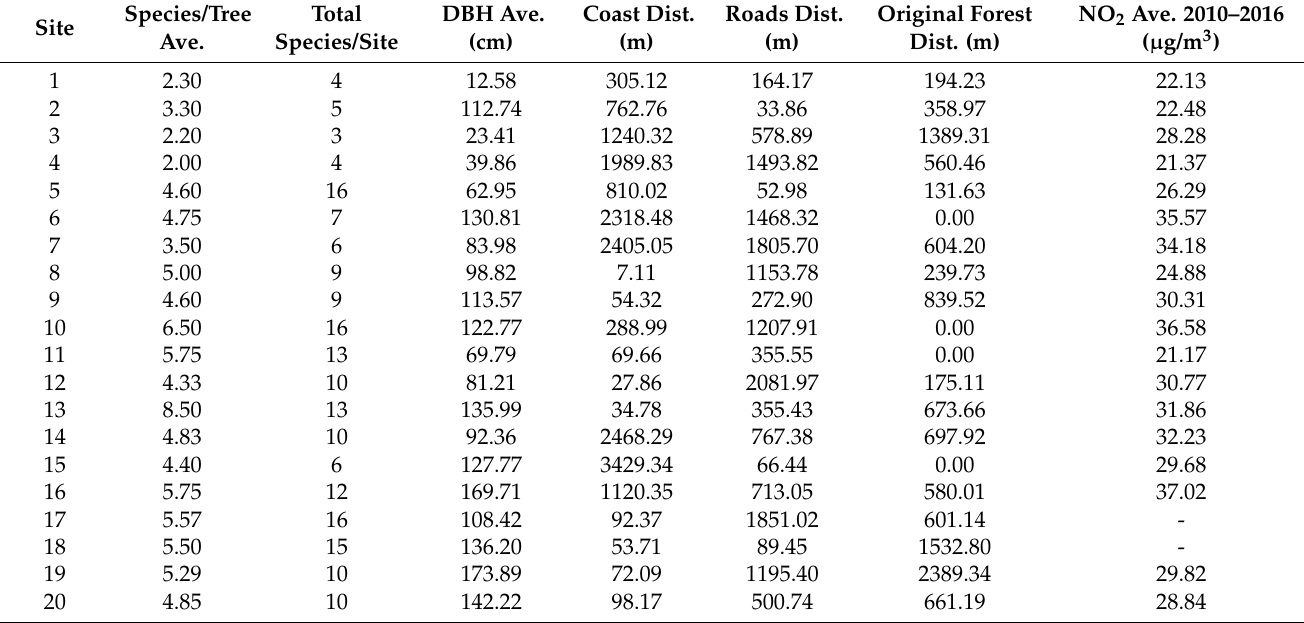
Table 3. Results of lichen data sampling and values of the variables for each